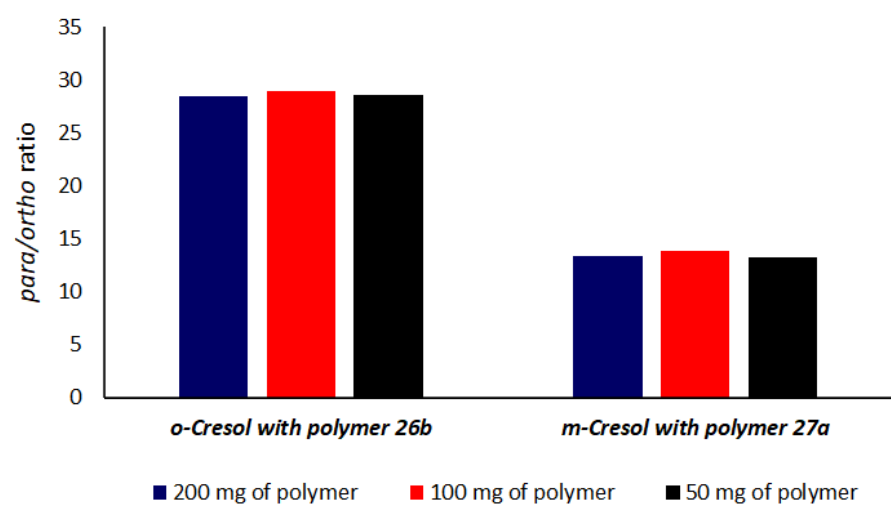
Figure 12. Chlorination of cresols with different amounts of certain catalysts. Conditions: For o -cresol: 100 mmol o -cresol; 105 mmol SO 2 Cl 2 ; 500 mg AlCl 3 ; 20 ◦ C, 4 h; for m -cresol: 100 mmol o -cresol; 106 mmol SO 2 Cl 2 ; 200 mg AlCl 3 (100 mg for the case of 50 mg catalyst); room temperature, 4 h.